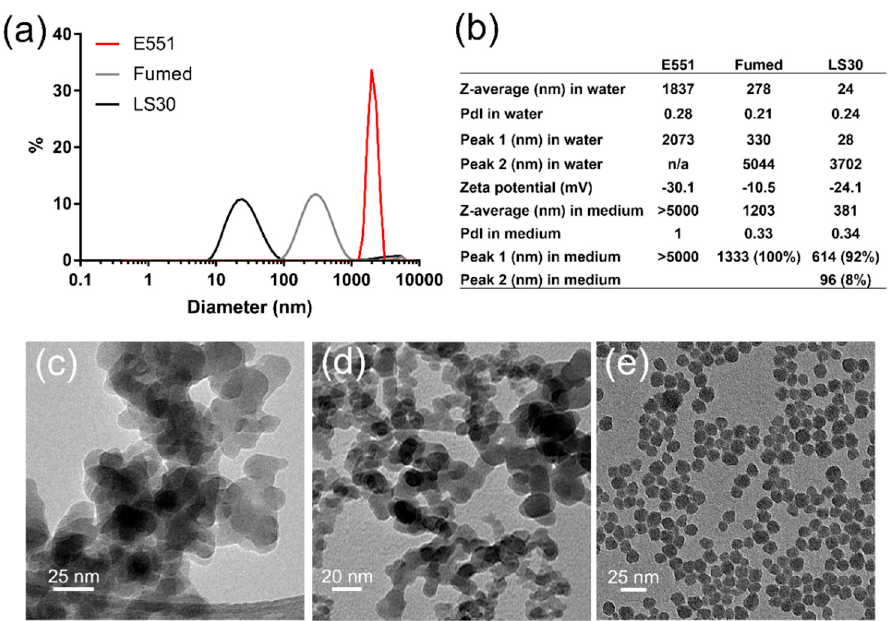
Figure 1. Physico-chemical characterization of SiO 2 particles. ( a ) Size distribution of SiO 2 particles in water; ( b ) hydrodynamic diameter, polydispersity index and zeta potential for SiO 2 particles dispersed in water; ( c ) TEM image of E551; ( d ) TEM image of Fumed silica; and, ( e ) TEM image of LS30.